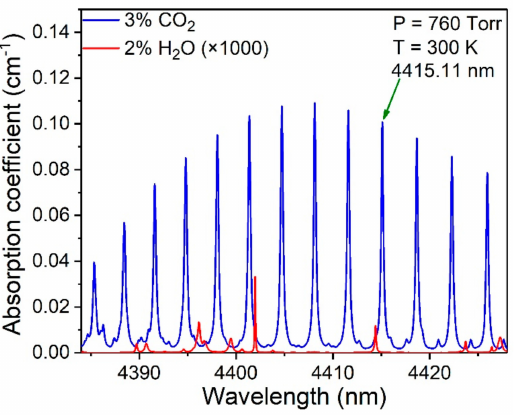
Figure 1. Absorption lines for 3% CO 2 and 2% H 2 O in the ~4.4 µ m spectral region based on the HITRAN 2016 database.